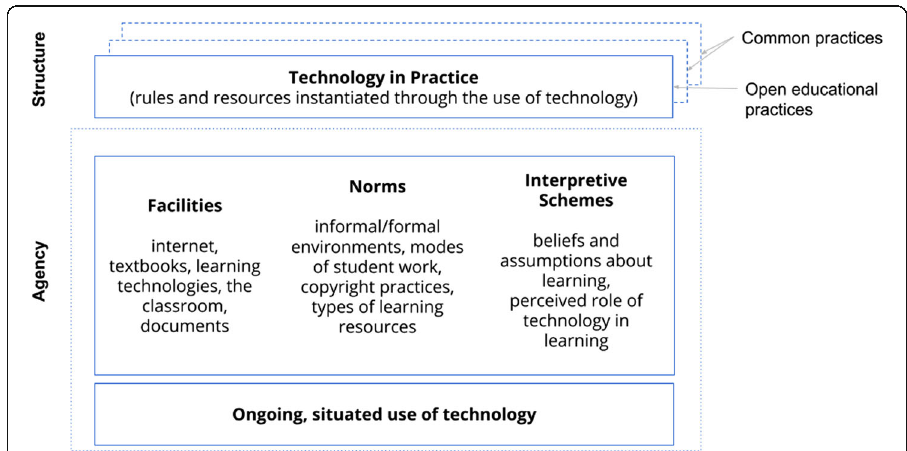
Fig. 1 Technology use in practice. Adapted from “ Using Technology and Constituting Structures: A Practice Lens for Studying Technology in Organizations, ” by W. J. Orlikowski, 2000, Organization Science, 11(4), 404